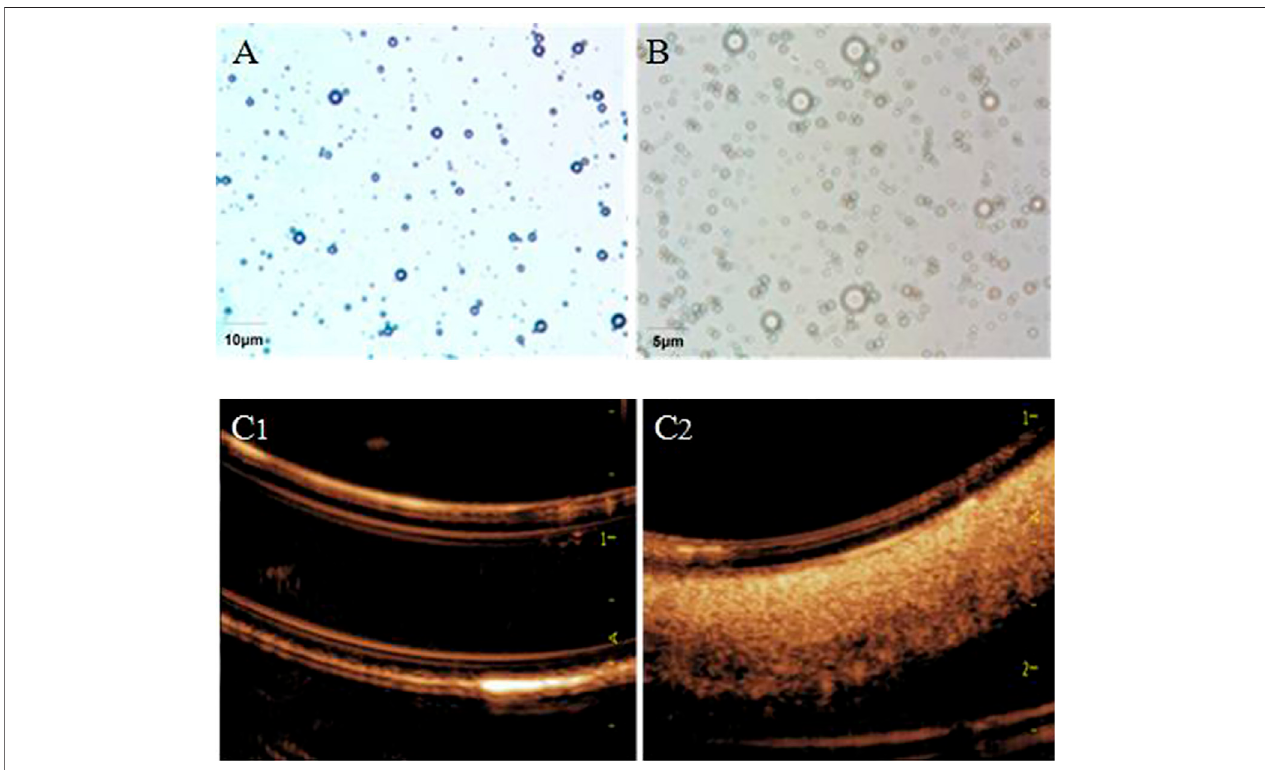
FIGURE 1 | Light microscope view of cationic lipid microbubbles (A) and aFGF – NP + CPMBs (B) . Effect of aFGF – NP + CPMBs contrast – enhanced ultrasound in vitro (C1) and (C2), Comparison of echocardiography before and after aFGF – NP + CPMBs administration. aFGF, acidic fi broblast growth factor; NP, nanoparticles; CPMBs, cationic lipid microbubbles. Improvement of cardiac function dysfunction in DOX – HF.